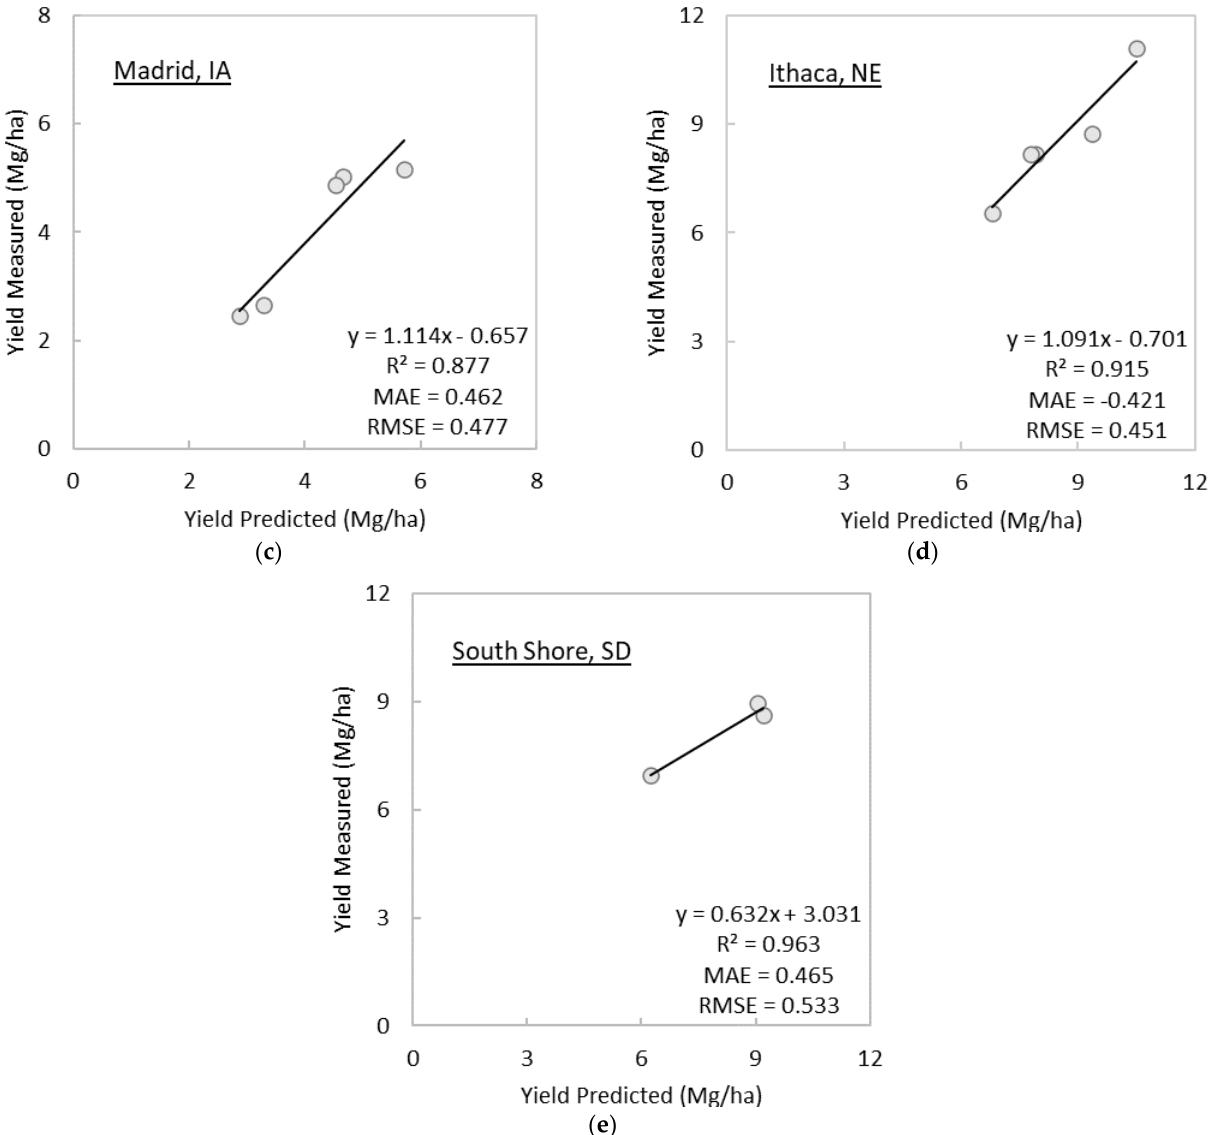
Figure 6. Examples of scatter plots of measured switchgrass yields and switchgrass yields predicted based on the linear regression model output using the green normalized difference vegetation index across the ( a ) Brighton, Illinois (IL); ( b ) Urbana, IL; ( c ) Madrid, Iowa (IA); ( d ) Ithaca, Nebraska (NE); and ( e ) South Shore, South Dakota (SD), sites.